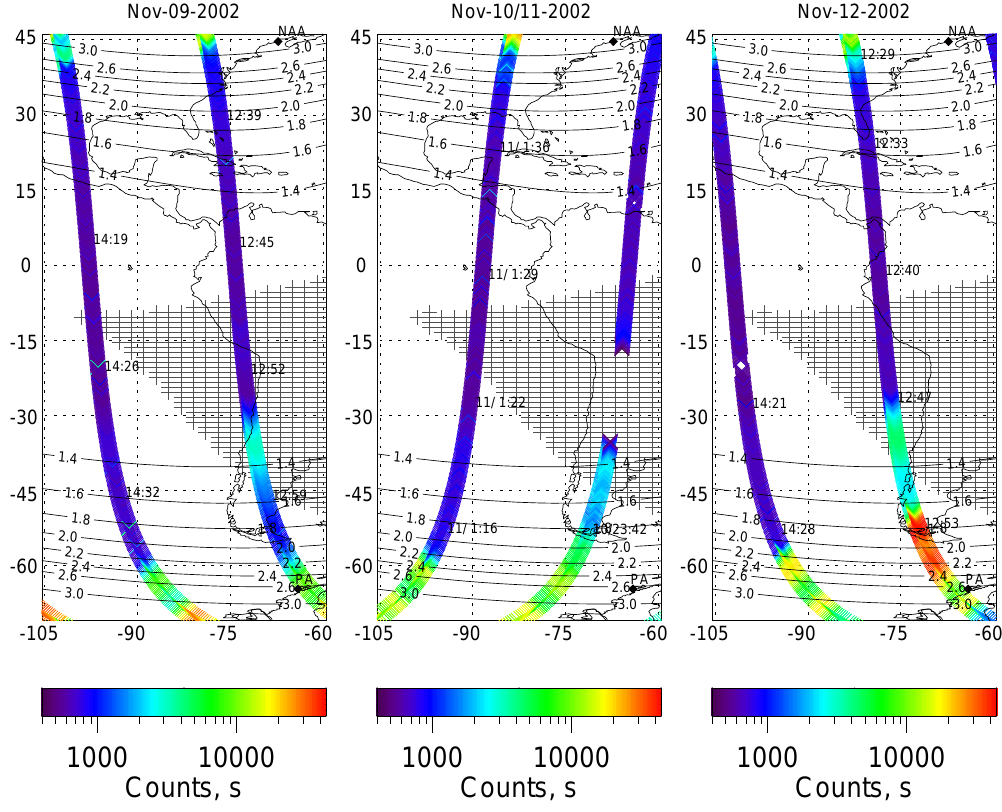
Fig. 2. Geographic locations of X-ray counts (60–150keV) during two consecutive CORONAS-F orbits displayed in each panel, the times of which are shown in hours and minutes, UT . Footprints of several L shells and stable trapped region (crosshatched) at 500 km are shown for reference along with the location of the Palmer station (PA) and NAA VLF transmitter. Here we have data with the time resolution of 4 s .